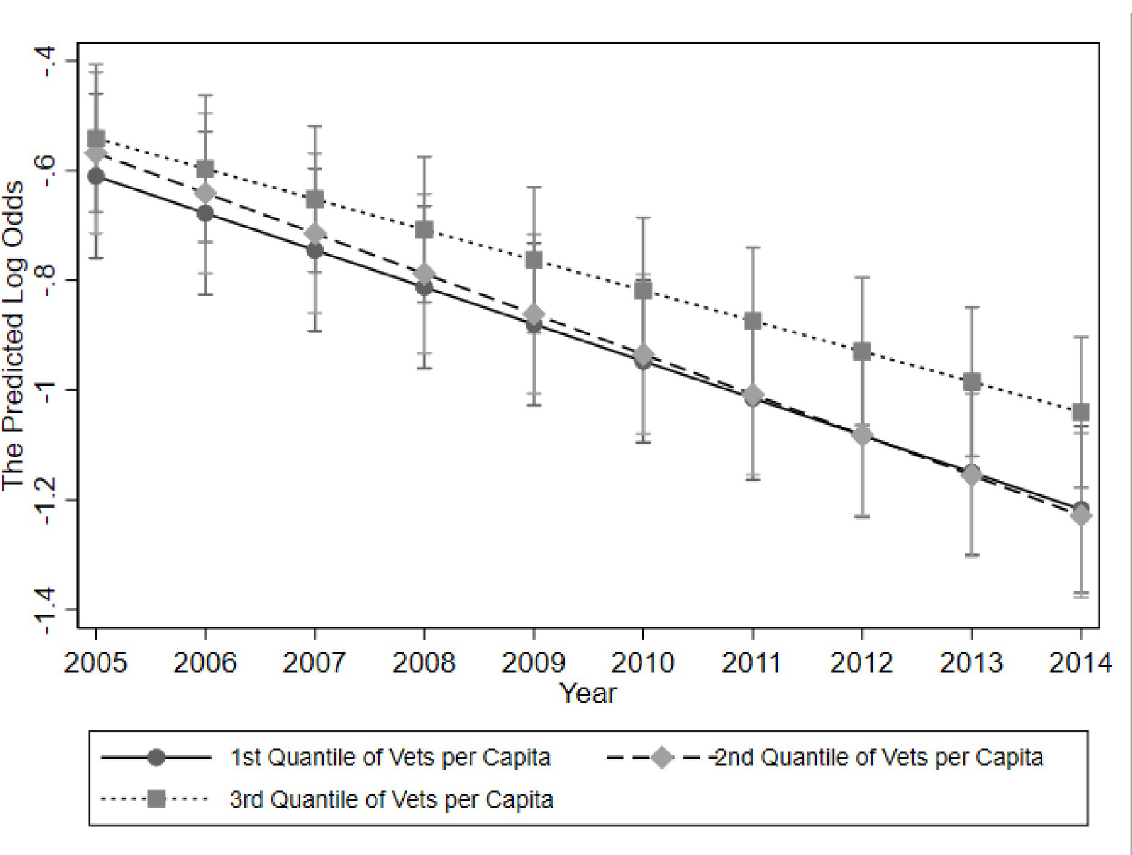
Fig 2. Predicted log odds of a call to the APCC being from a veterinarian from 2005–2014 by quantile of veterinarians per 100,000 population in a